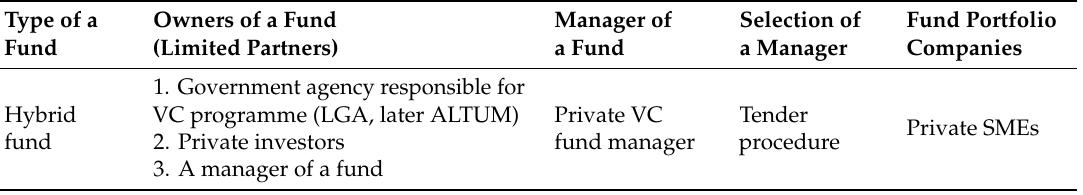
Table 1. Structure of the provision of public venture capital (VC) support in